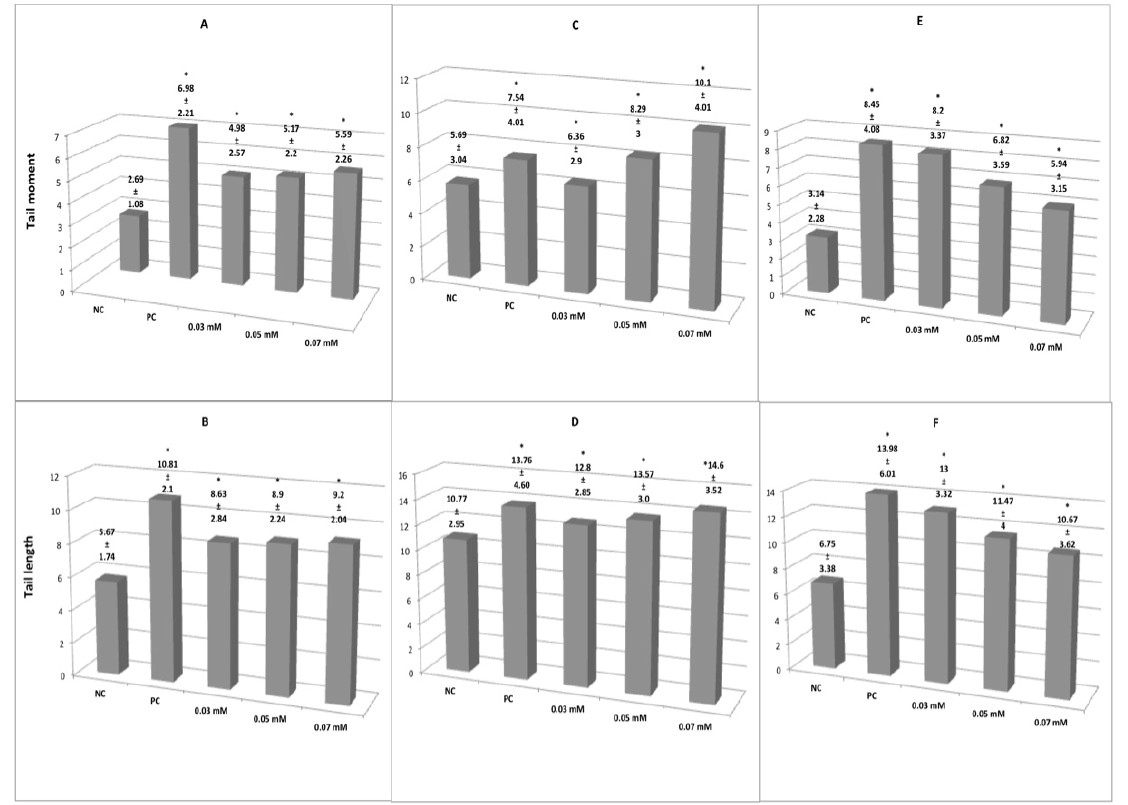
Figure 1. Tail moment and tail length in erythrocytes of Oreochromis niloticus ( A , B ) and Ambystoma mexicanum ( C , D ) and human lymphocytes ( E , F ) exposed to different concentrations of glyphosate. NC, negative control; PC, positive control. All glyphosate concentrations in the three organisms studied were significantly different from NC